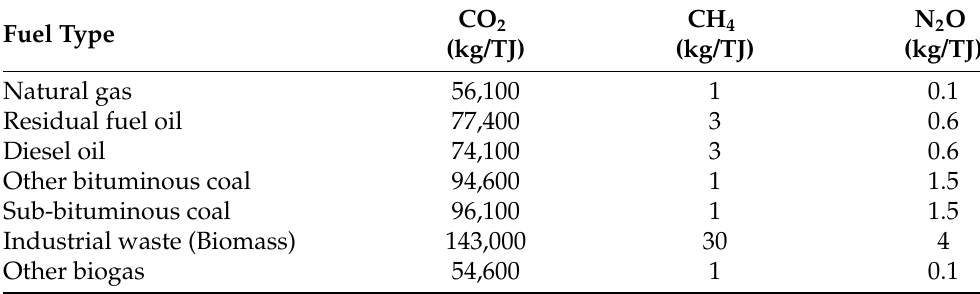
Table 1. Emission factors for stationary combustion in the energy industries